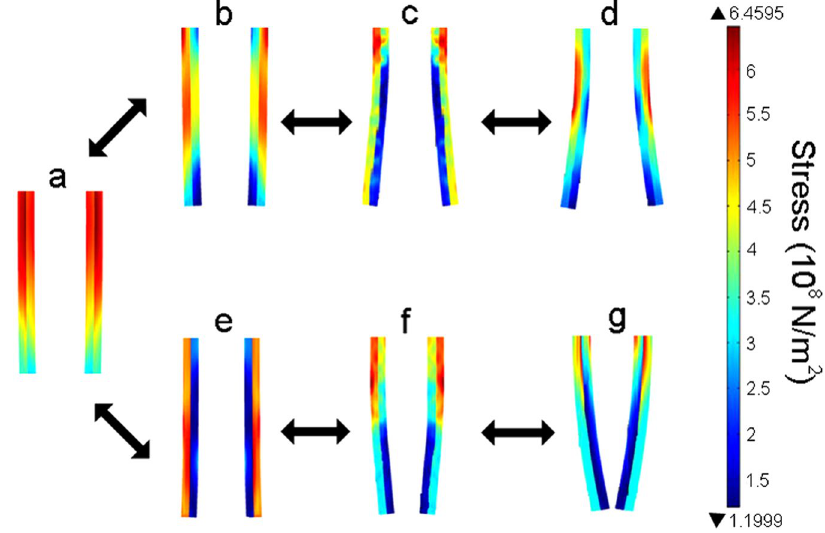
Figure 5. Snapshots of the finite element simulation of the bending process and the stress distribution of PBONF-reinforced CNT/PVA bilayer actuators when switching RH from 80% ( a ) to 20% ( b – d ) or from 80% ( a ) to 98% ( e – g